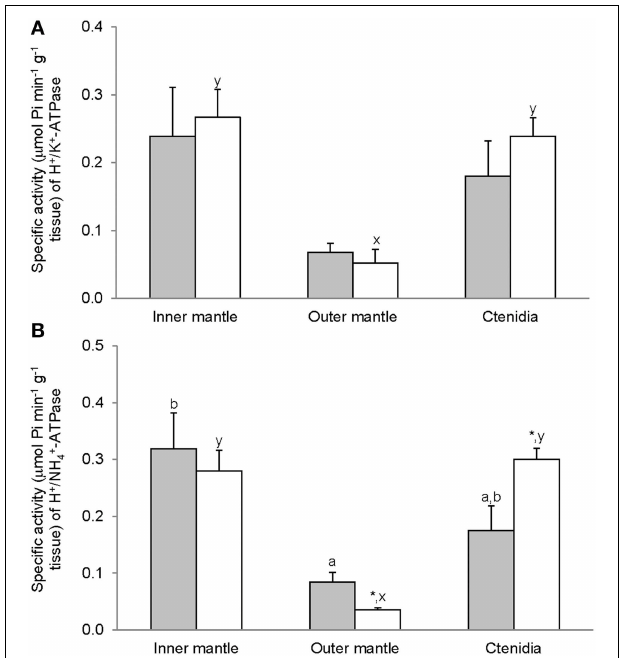
FIGURE 4 | Mass-specific activity ( µ mol Pi min − 1 g − 1 tissue) of oligomycin-sensitive H + /K + -ATPase (HKA), activated by (A) H + /K + or (B) H + /NH + 4 , from the inner mantle, the outer mantle, and ctenidia of Tridacna squamosa exposed to 12h of darkness (control; closed bar) or 12h of light (open bar). Values represent means + S.E.M. ( N = 4 ). Means not sharing the same letter (a, b for darkness, or x, y for light) are significantly different from each other ( P < 0 . 05 ). ∗ Significantly different from the control value ( P < 0 . 05 ).